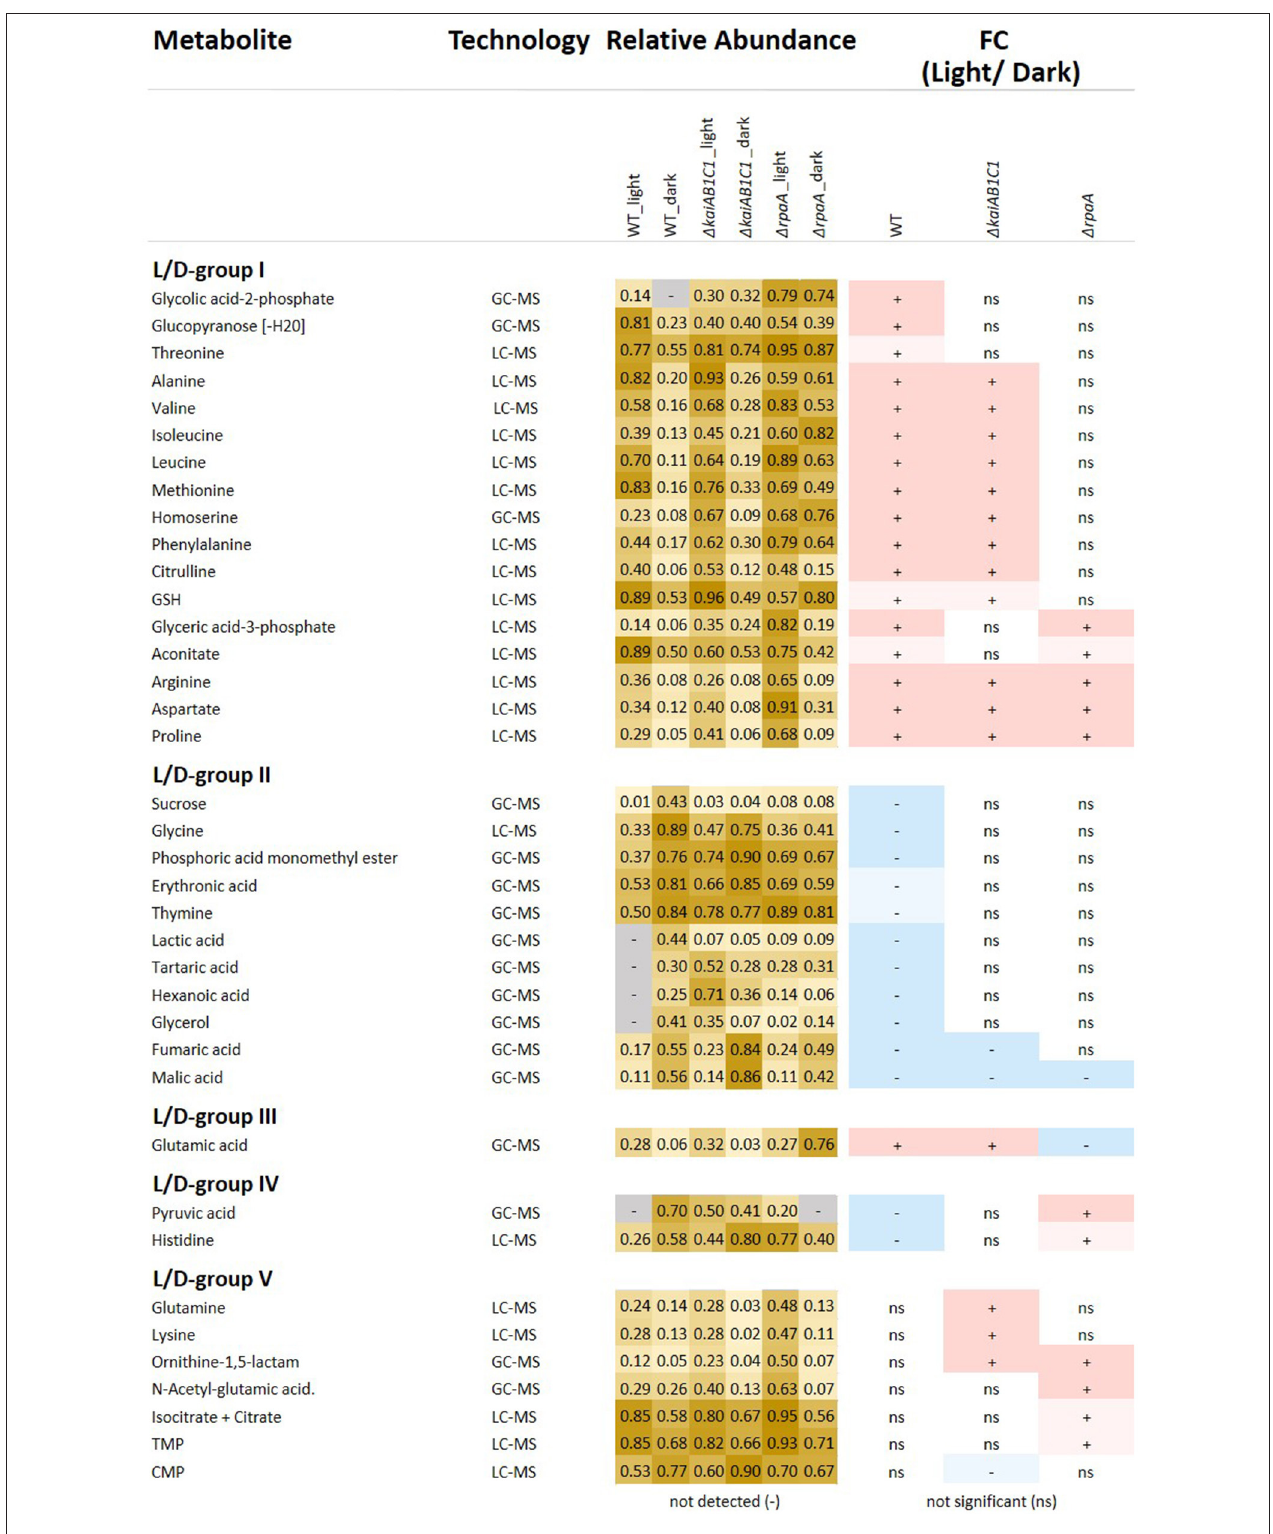
FIGURE 5 | Relative abundances and fold changes (FC) of metabolite concentrations in the L phase compared to the D phase. The figure includes identified metabolites that exhibited significant changes in L metabolism compared to D metabolism (Tukey test P < 0.05). Fold changes are color-coded as follows: significant increases, red ( > 2-FC), light red ( < 2-FC), significant decreases, blue ( < 0.5-FC), and light blue ( > 0.5-FC); the complete numerical data are provided